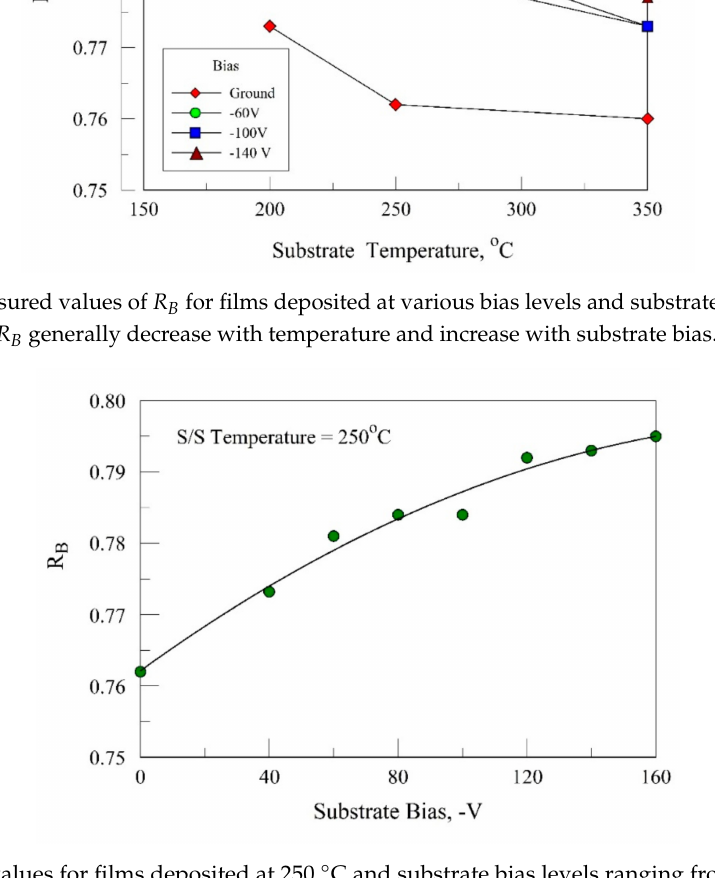
Figure 5. R B values for films deposited at 250 ◦ C and substrate bias levels ranging from 0 to − 160 V. The line shown is a parabolic fit to the